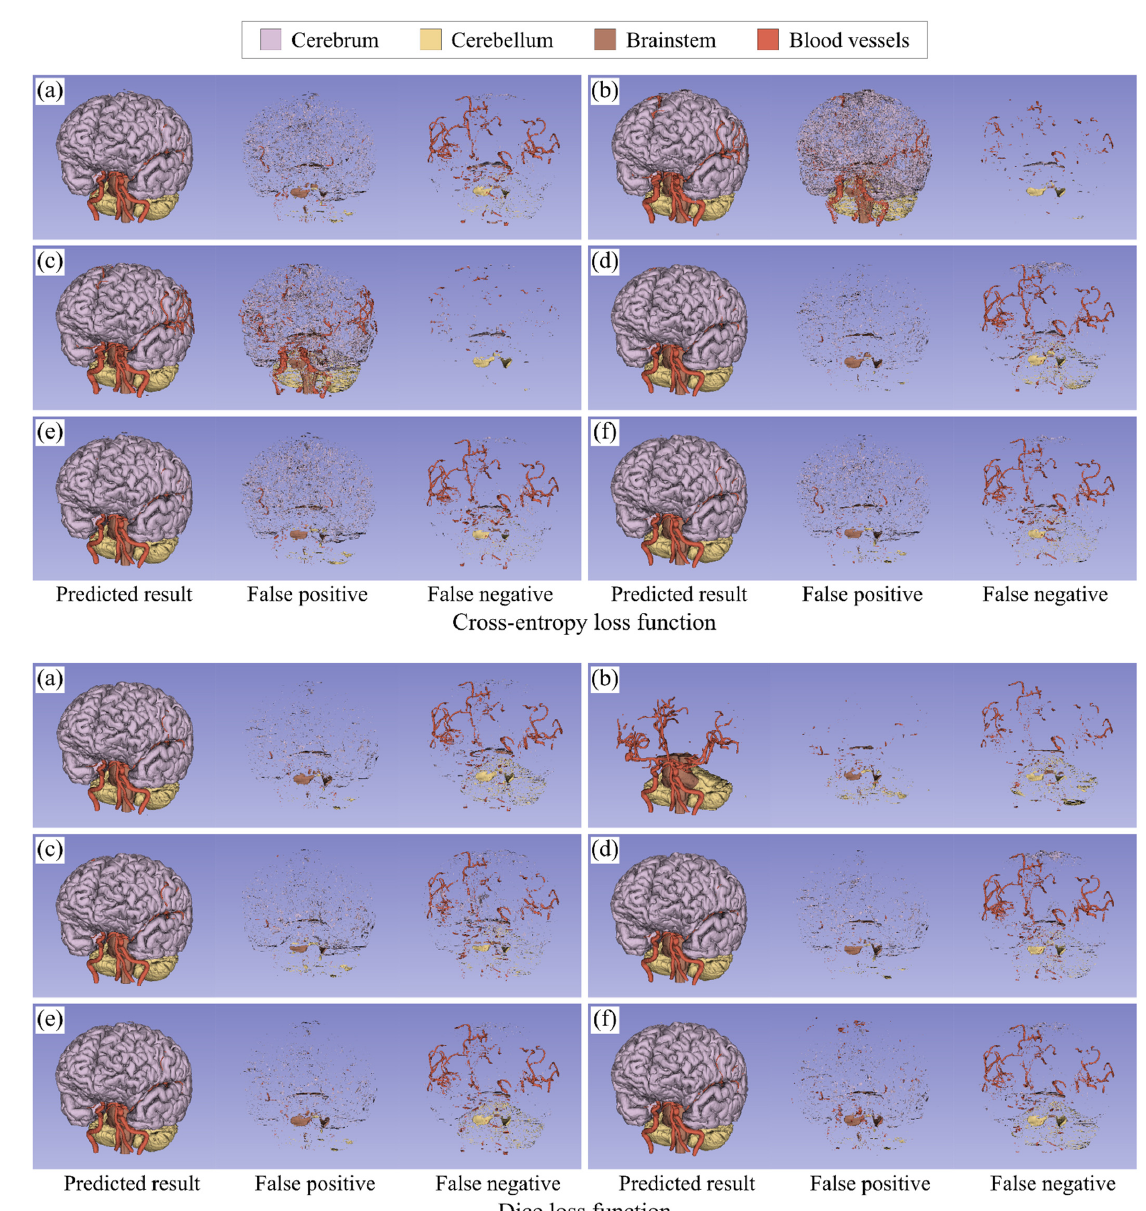
Figure 7. Visualization of the segmentation results in the five-class segmentation task. ( a ) No weighting, ( b ) inverse frequency weighting, ( c ) inverse median frequency weighting, ( d ) focal weighting, ( e ) distance transform map-based weighting, and ( f ) distance penalty term-based weighting. The segmentation results include the predicted results (left), the false positives (middle), and the false negatives (right). Note that in the result of Dice loss function with inverse frequency weighting, there are no true positive voxels in the cerebrum class and most of the background region were overestimated as the cerebrum class, but the false positives and false negatives in the cerebrum class were excluded from the figure for better visualization.